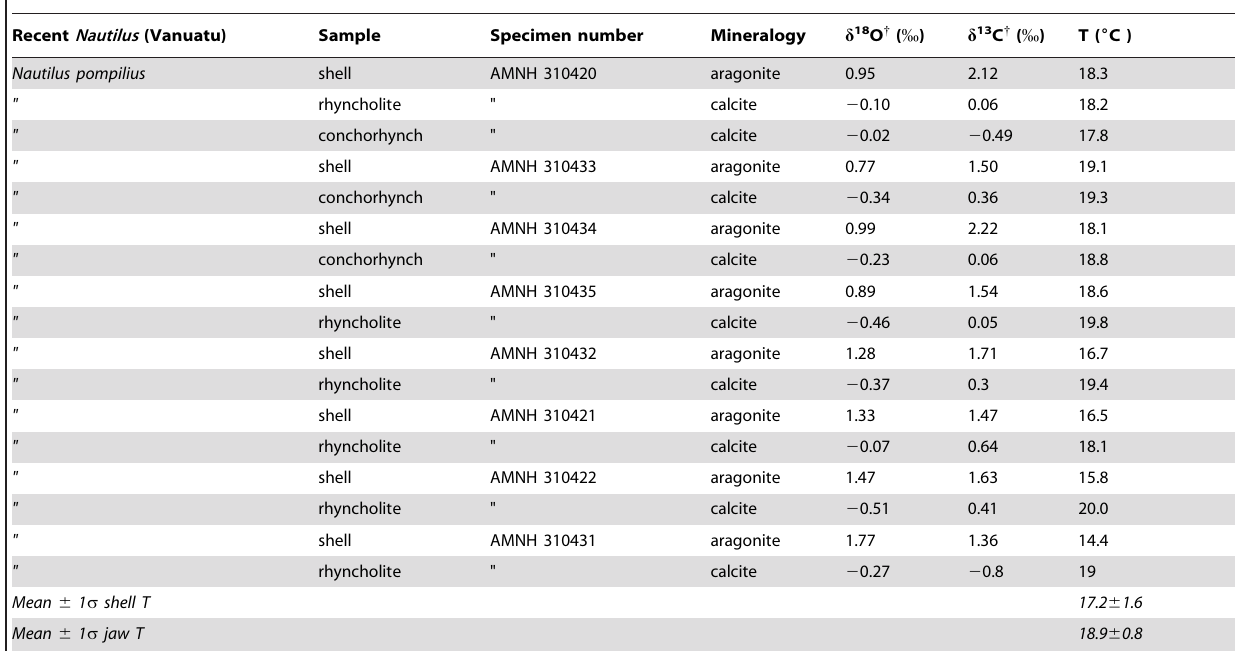
Table 1. Isotope data for Nautilus .